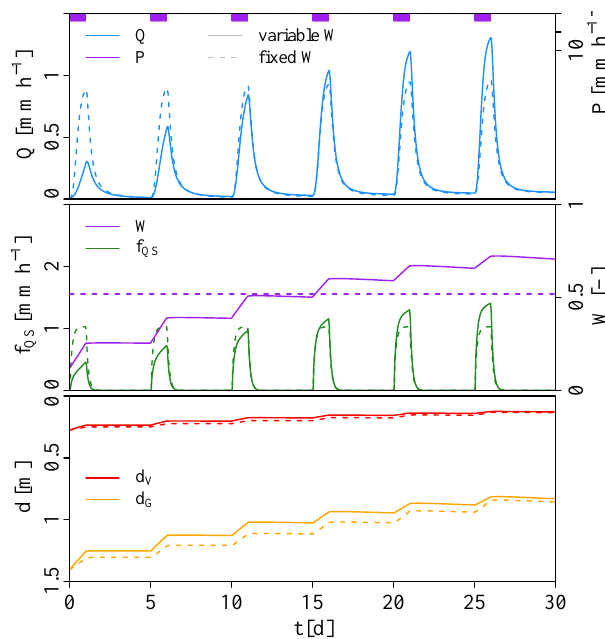
Figure 5. The isolated effect of including a wetness-dependent di- vider between slow and quick flow routes. Results of a numer- ical experiment with (solid) and without (dashed) a variable di- vider ( W ; the wetness index). A change in W does not only af- fect quickflow ( f QS ), but propagates through the model and alters nearly all model variables: storage deficit ( d V ), groundwater depth ( d G ) and discharge ( Q ). We used parameter values obtained for the Hupsel Brook catchment (Brauer et al., 2014, i.e. c W = 365mm, c V = 0 . 2h, c G = 5 × 10 6 mmh, c Q = 3 . 3h, c D = 1500mm, a S = 0 . 01 and the local Q – h relation and soil parameters). See Table 1 for a list of all variable